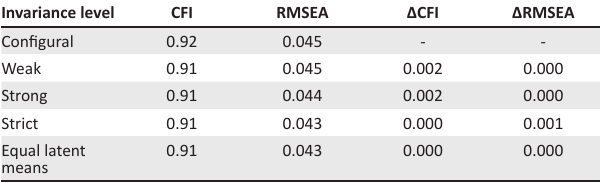
BIC, Bayesian information TABLE 3: Fit measures and changes in fit measures. Invariance level